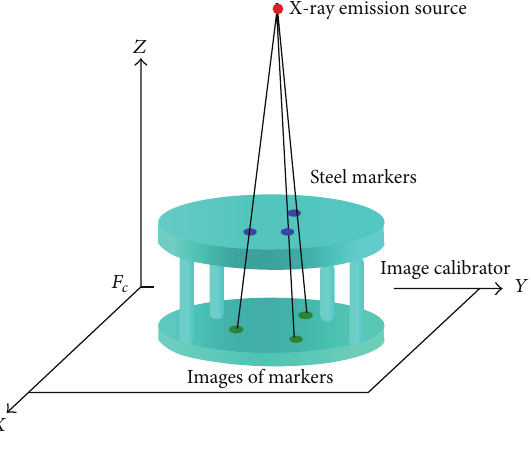
Figure 2: The X-ray projection